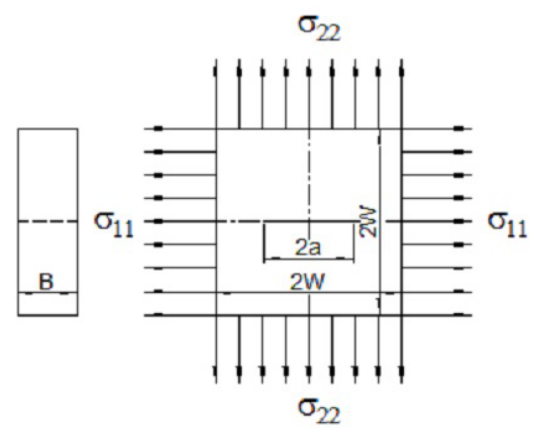
Figure 3: CCSP(BT): 2 a – crack length, 2 W – specimen width,